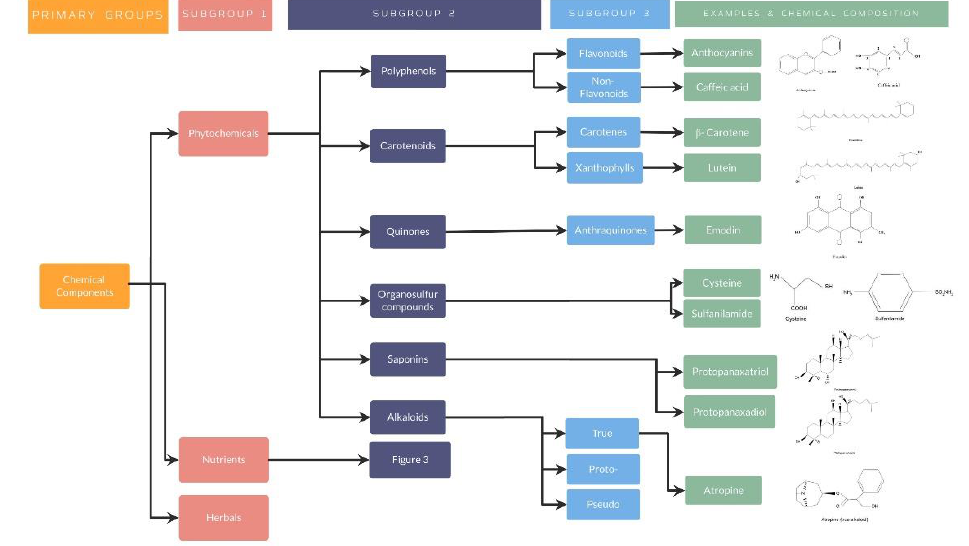
Figure 2. Phytochemicals classification, examples, and chemical composition.